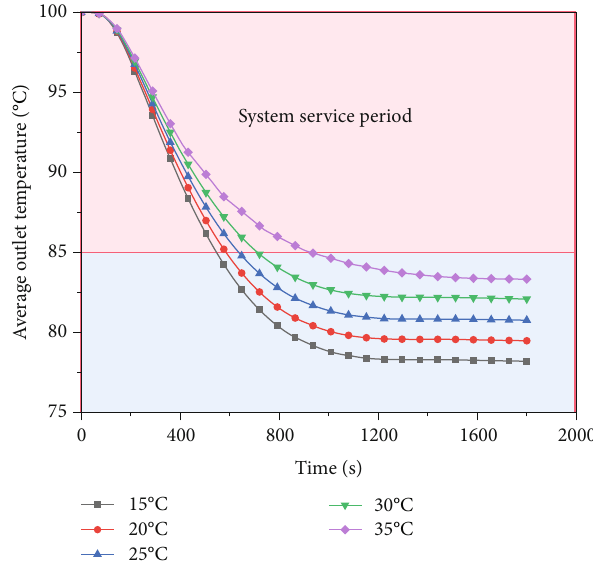
Figure 8: Average outlet temperature of fractured rocks with fi ve di ff erent patterns.